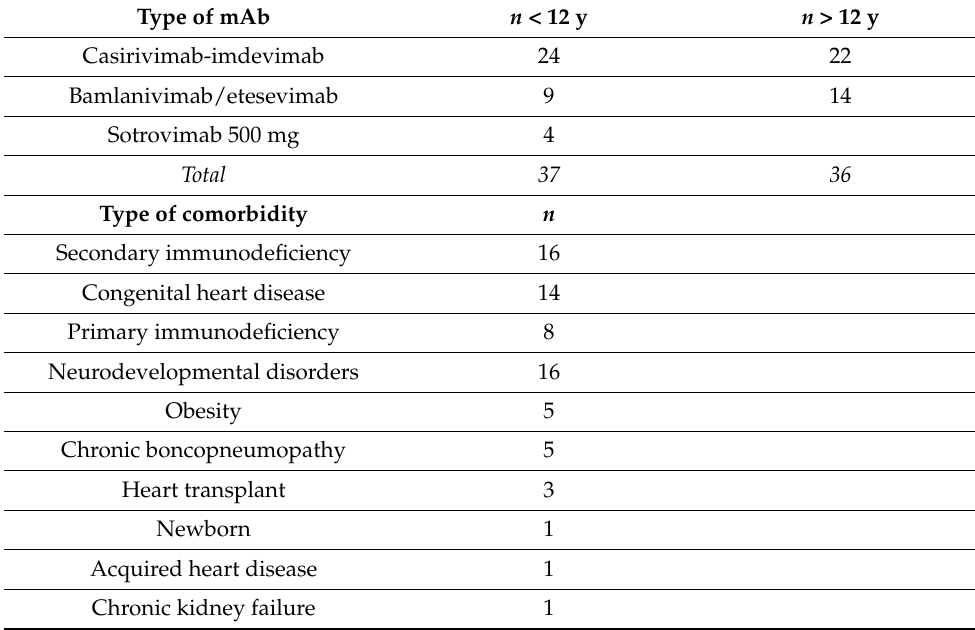
Table 1. Use of monoclonal antibodies for age and comorbidities of our study group. Type of mAb n < 12 y n > 12